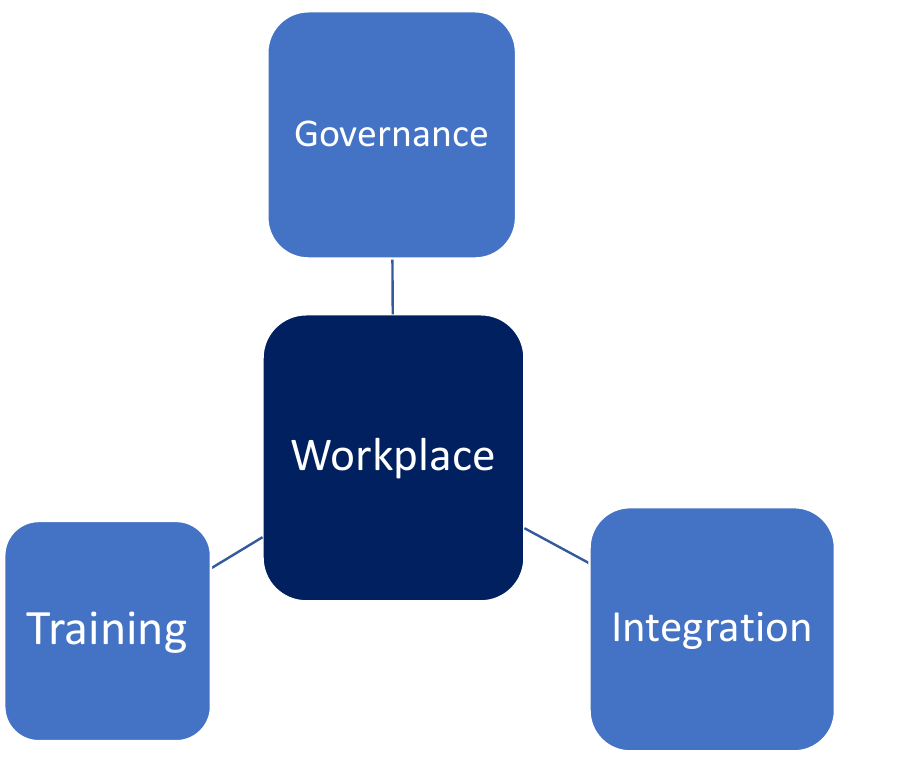
Figure 2. A model of workplace postvention (2022).